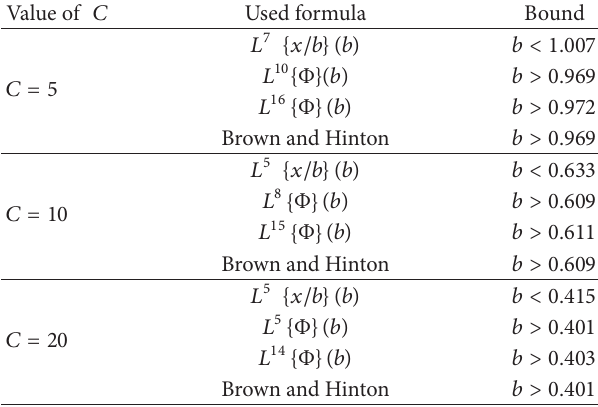
Table 3: Comparison of bounds for 𝑏 in Example